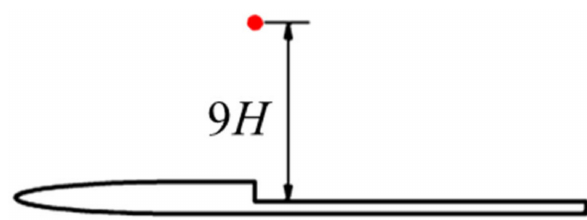
Figure 22. Monitoring point of snowflake